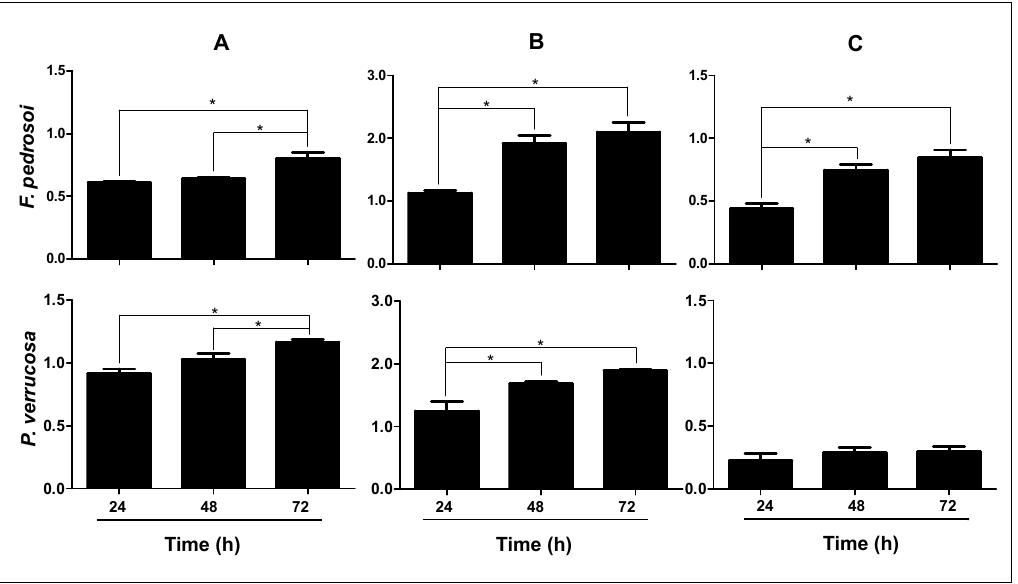
Figure 2. Biofilm formation by F. pedrosoi and P. verrucosa on a polystyrene surface. Fungal cells (1 × 10 6 ) were incubated for 24, 48 and 72 h at 37 °C in 96-well polystyrene plates containing RPMI medium. After incubations, the following parameters were assessed: ( A ) cell viability using XTT reduction assay (490 nm), ( B ) biomass after the incorporation of crystal violet in methanol-fixed biofilm (590 nm), and ( C ) extracellular matrix after the incorporation of safranin in non-fixed biofilm (590 nm). The data were expressed as means ± SDs. Asterisks represent statistical significance ( p < 0.05).